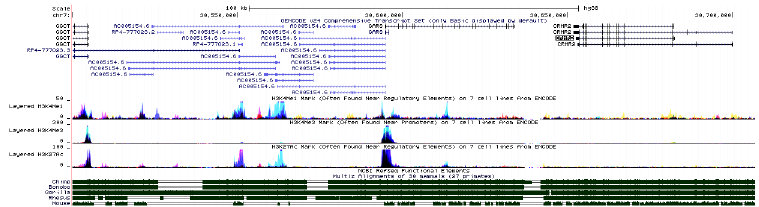
Fig 5. Multiple sequence alignment and histone marks of the genomic region of AC005154 . 6 (USCS genome browser GRCh38/hg38; http://genome.ucsc.edu/).